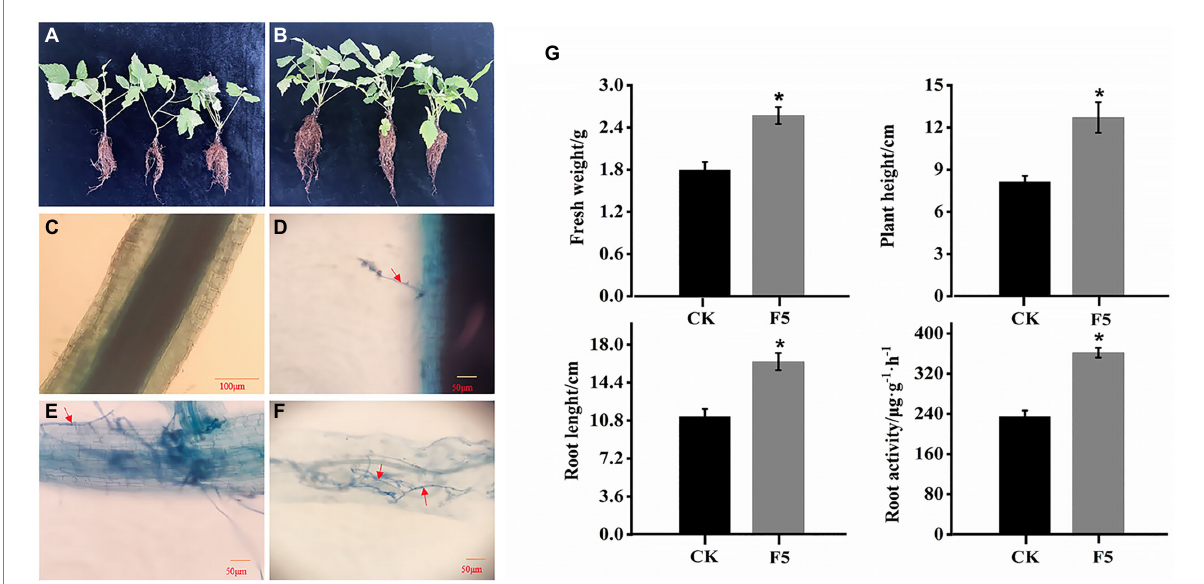
FIGURE 1 Effects of F5 on the growth of raspberry. (A) The growth of raspberry with F5. (B) The growth of raspberry with no microbial inoculation. (C–F) Dark septate endophytes (DSEs) stained with trypan blue in raspberry root tissue. (C) CK (control check, without inoculation). (D) BI (presymbiotic phase, 3 weeks after inoculation). Mycelia infecting raspberry cells. ( E,F) UI (symbiotic phase, 5 weeks after inoculation), intercellular hyphae formed hyphal nets. The red arrow indicates the fungal mycelium. (G) Growth index measured using fresh weight, plant height, root length, and root